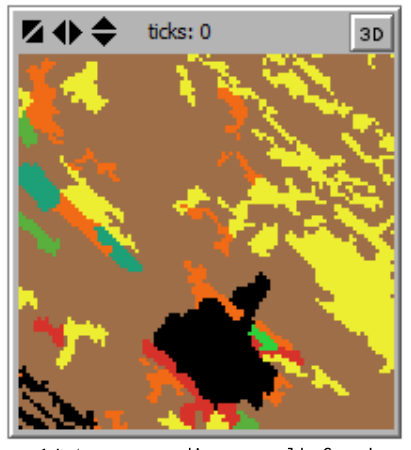
Figure 14. An average diverse world of workspace.